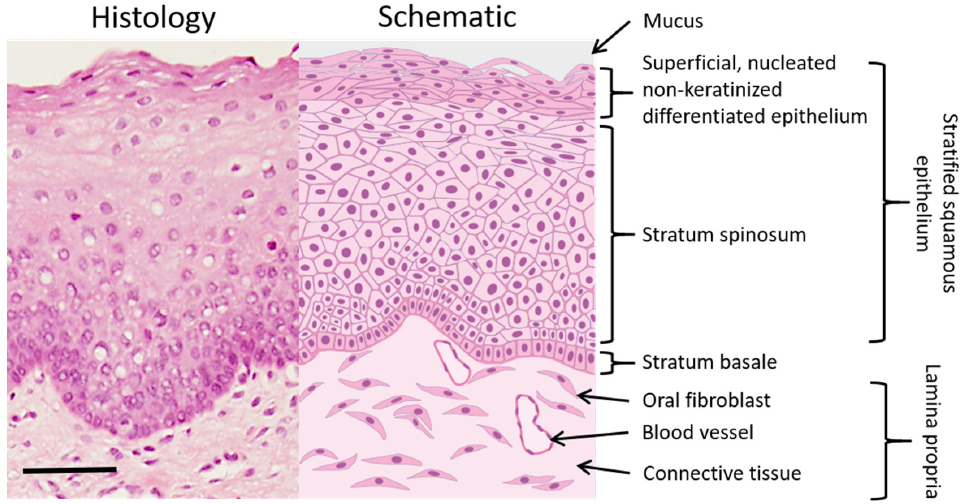
Figure 1. Histological ( left ) and schematic ( right ) image of the buccal oral mucosa (histological image courtesy of Prof. Keith Hunter, Unit of Oral Pathology, University of Sheffield). Scale bar = 100